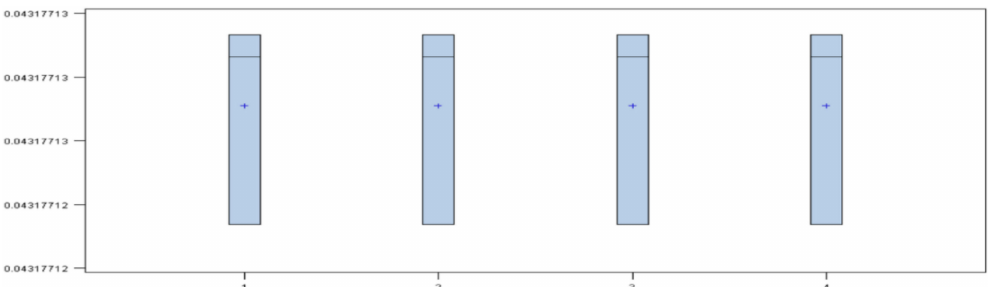
Figure 4. Box plot of the misclassification rate in gradient boosting models with sets of variables A and B.